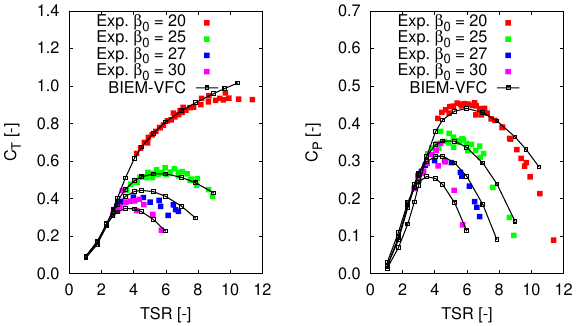
Fig. 6. Thrust (left) and power (right) coefficient curves of a model turbine with variable pitch over a 10 deg range. BIEM-VFC results from [14] compared with experimental data in [15].